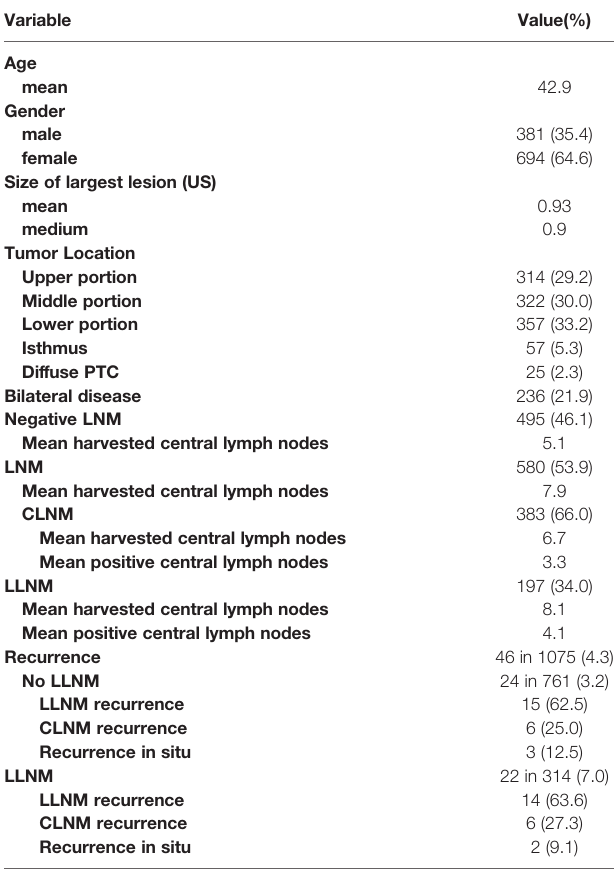
TABLE 1 | Demographics and clinical Characteristics of the